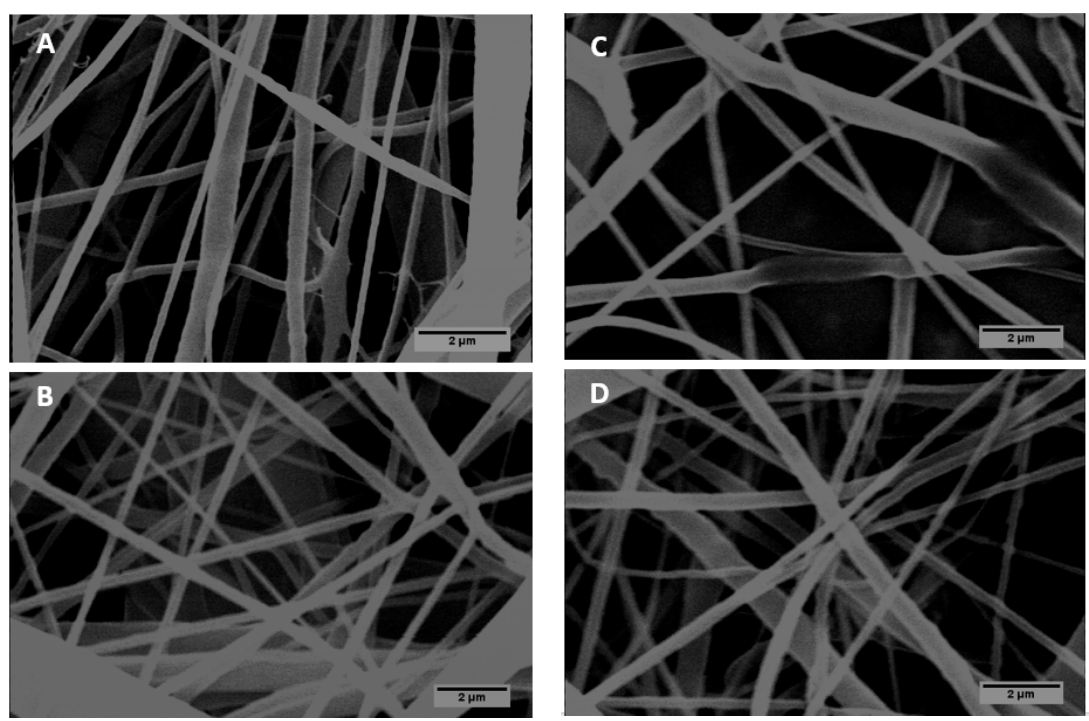
Figure 1. SEM images of the polycaprolactone (PCL) nanofibers electrospun at ( A ) 18 kV, ( B ) 20 kV, ( C ) 22 kV, and ( D ) 24 kV voltages. The images were measured at a magnification of ×8000 to ×10,000.